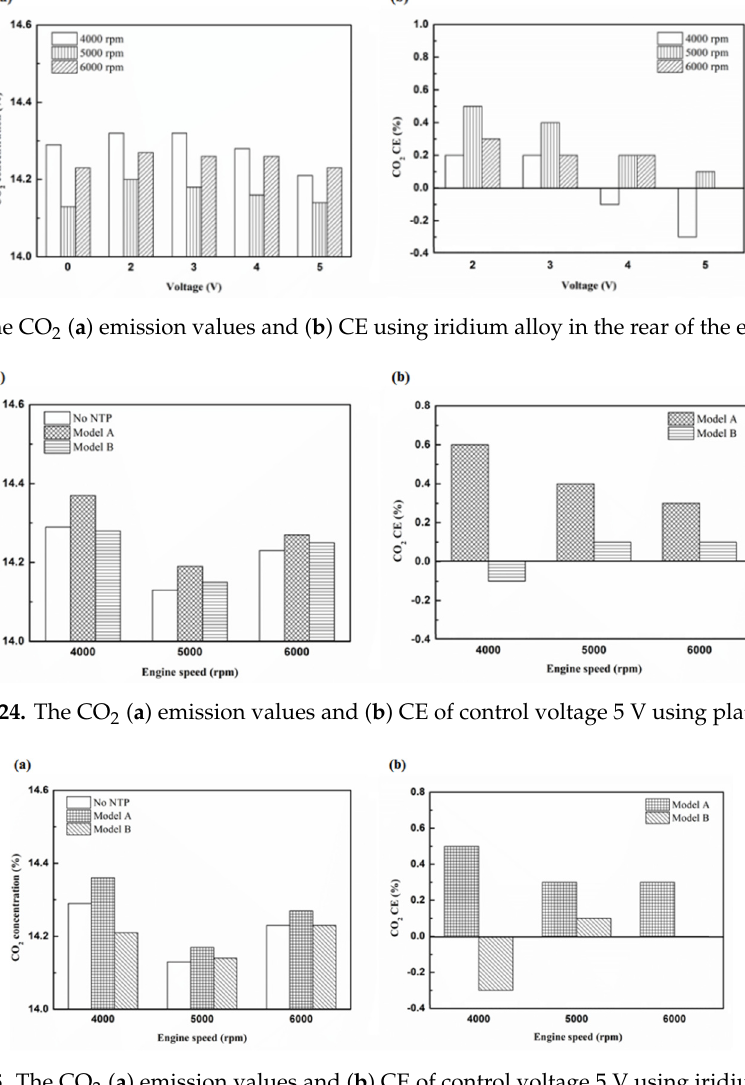
Figure 26. The CO 2 CE at control voltage 5 V. Table 8. The maximum and minimum values of CO 2 conversion efficiency at control voltage 5 V. Parameter